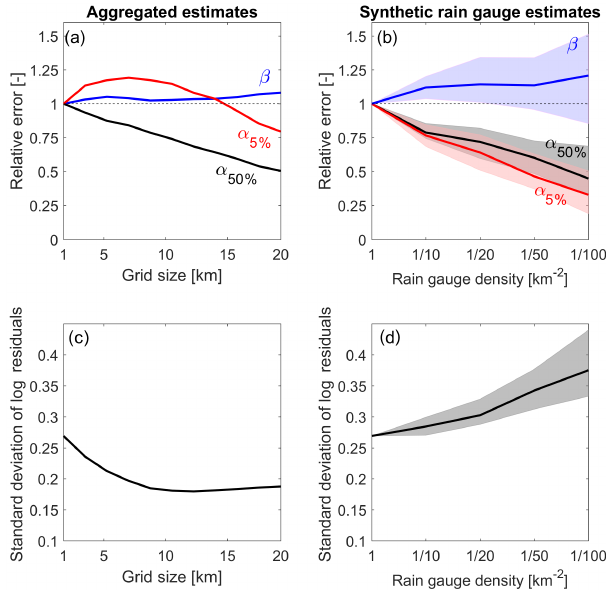
Figure 4. Relative error of the parameters of the debris flow occur- rence thresholds and associated regressions (a–b) and standard de- viation of the log residuals (c-d) obtained from spatial aggregation of rainfall (a, c) , and nearest-neighbour interpolation of synthetic rain gauge networks (b, d) – shaded areas represent the interquar- tile range of the Monte Carlo